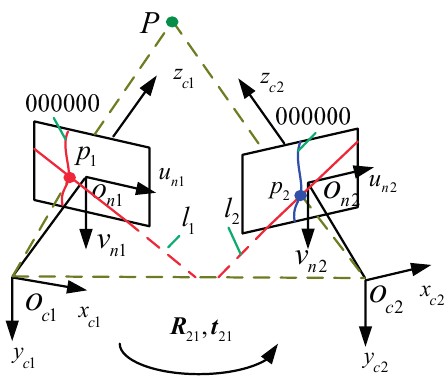
Figure 7. Schematic of the grating binocular vision sensor